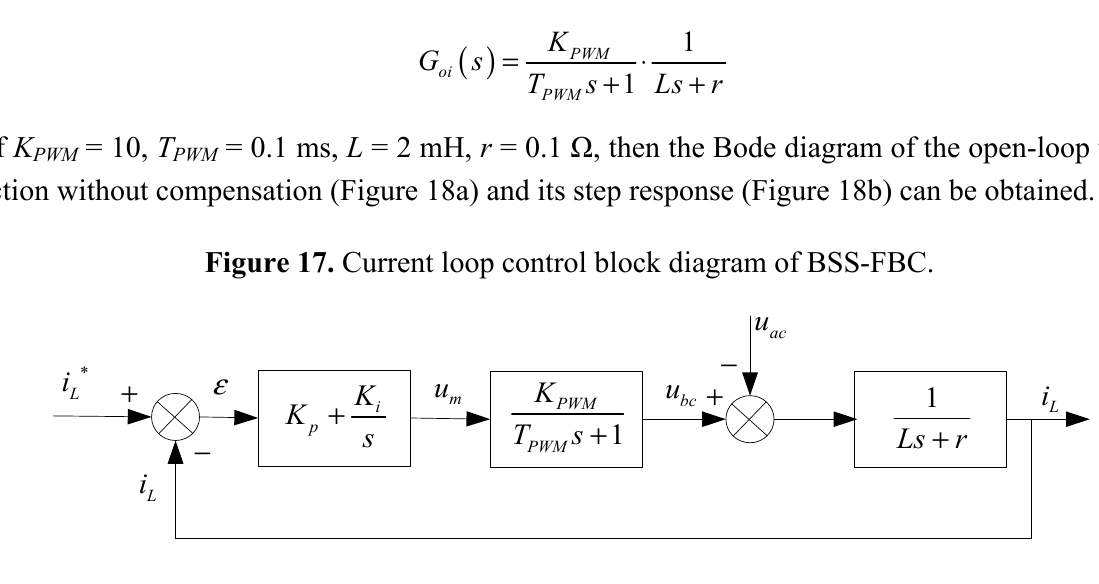
Figure 18. Open loop dynamic characteristic of current loop without compensator: ( a ) Bode diagram; ( b ) Step